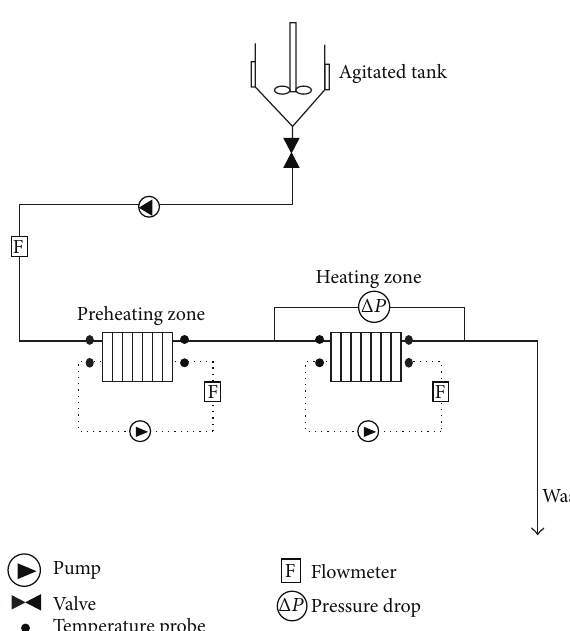
Figure 2: Schematic diagram of the experimental setup carried out for fouling runs with the 1% (w/w) WPI